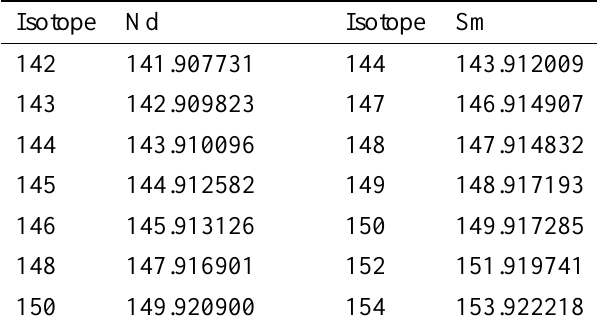
Atomic mass (Wapstra & Bos